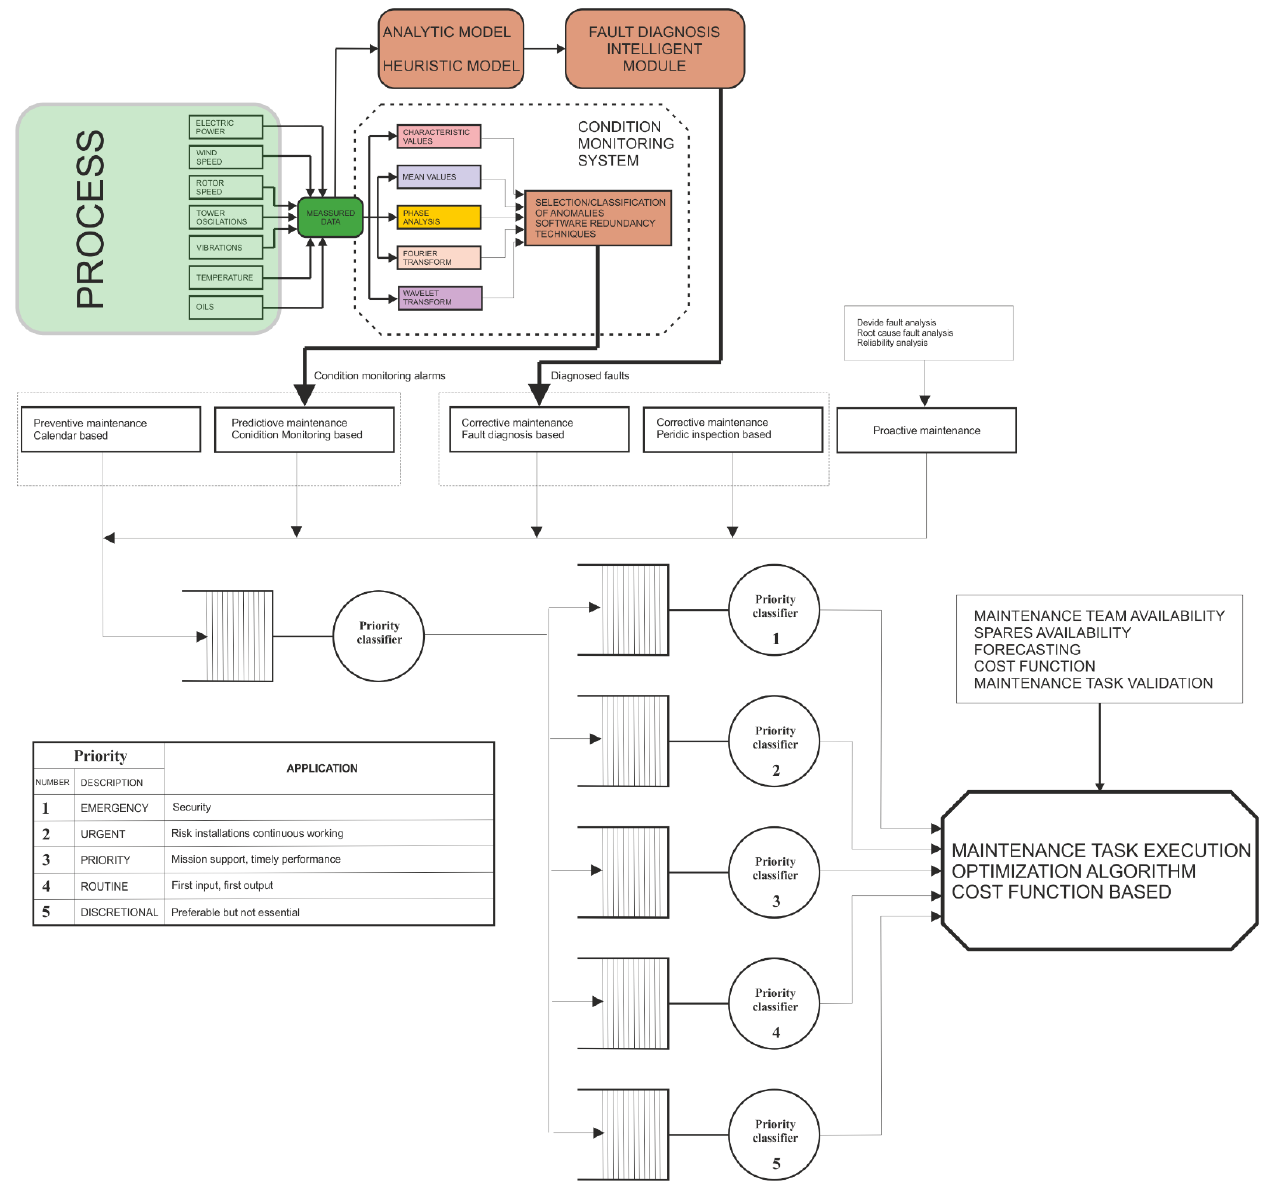
Figure 9. Block diagram of the proposed condition monitoring system.